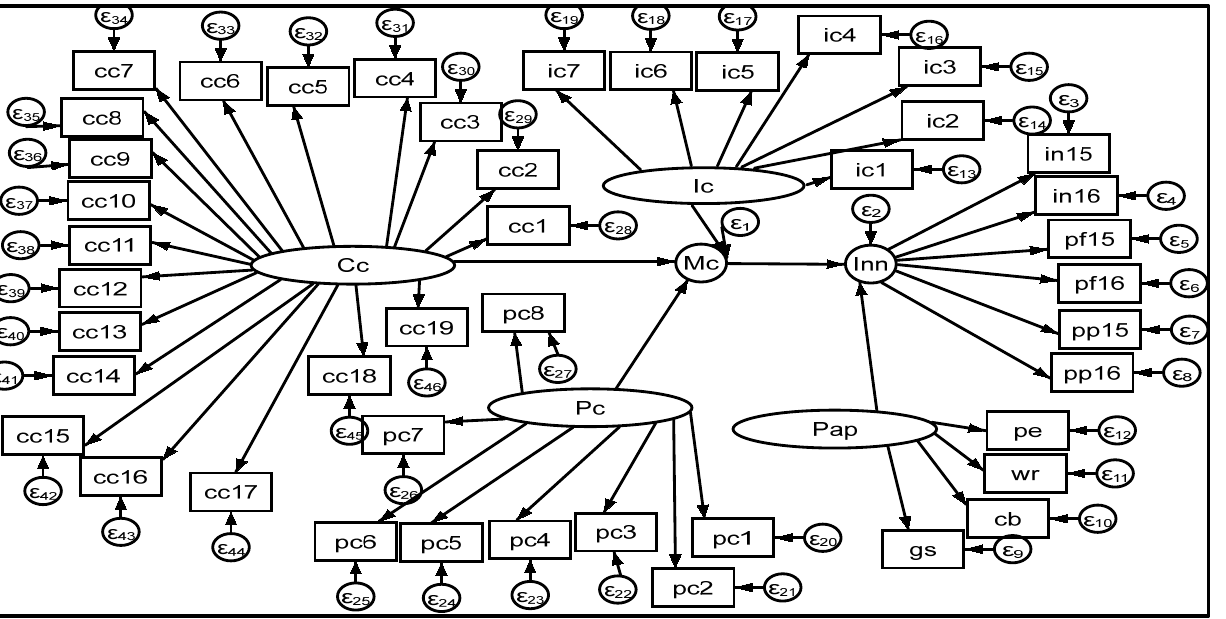
Figure A1. Structural Equation Model (SEM) conceptual framework for innovation as a measure of performance. Note: Definitions of the variable acronyms are provided in Table 3 in the text.